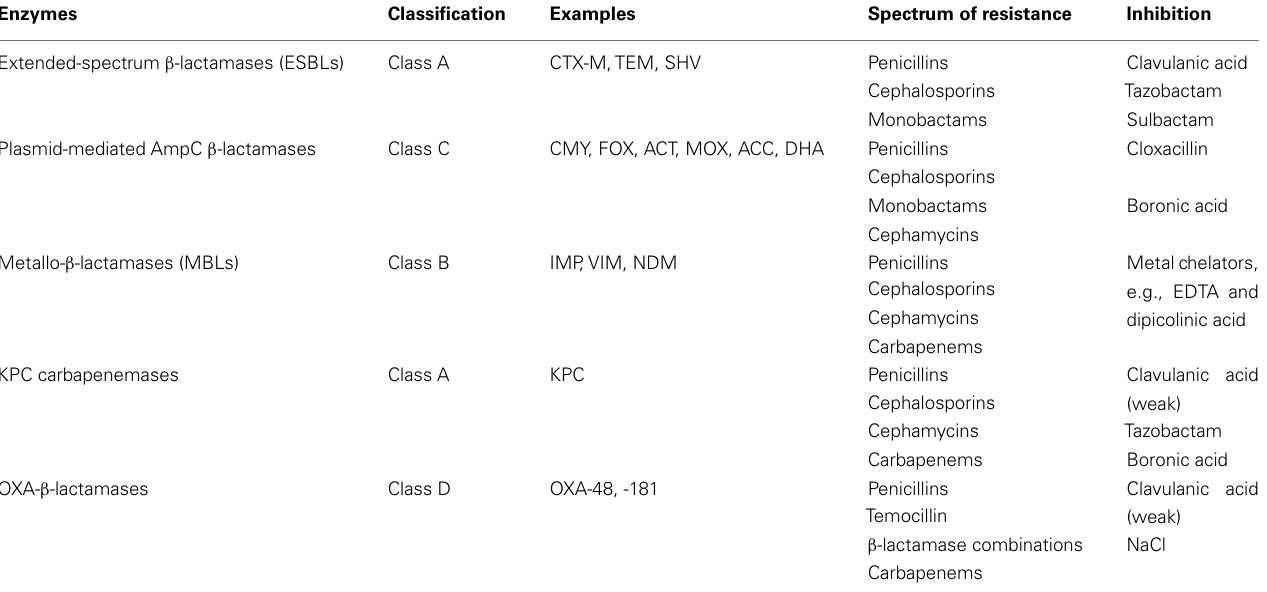
Table 2 | Newer β -lactamases in Escherichia coli